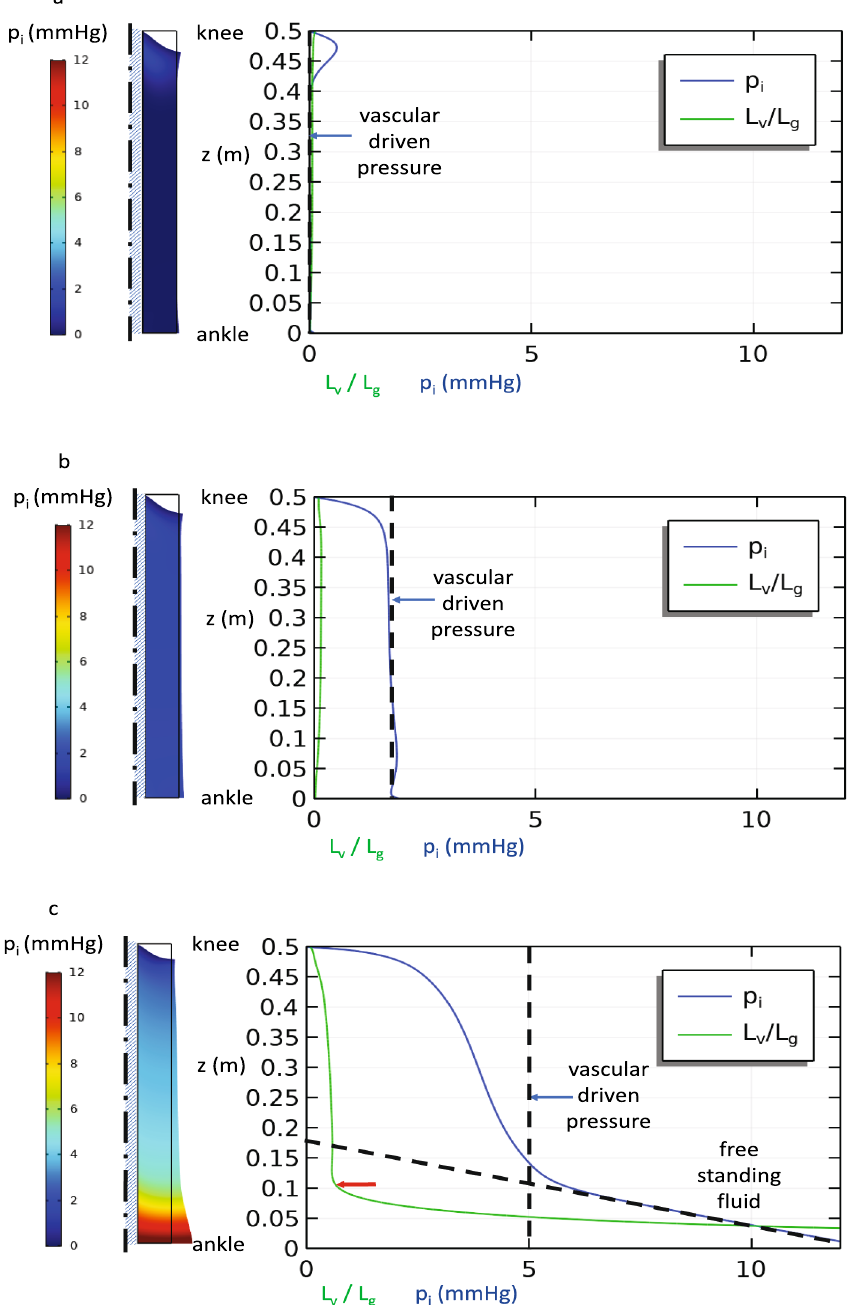
Figure 3. Baseline steady state simulation of the single-layer model with constant lymphatic clearance parameters, but increasing capillary pressure: ( a ) p c = 10 mmHg ( b ) p c = 20 mmHg, and ( c ) p c = 40 mmHg. IFP and L v / L g plotted along the outer surface of the leg. The dashed lines show the IFP expected due to a strictly local balance between the interstitial space and the vasculature as predicted by Eq. (12) at 0 mmHg for p c = 10 mmHg, 2 mmHg for p c = 20 mmHg, and 5 mmHg for p c = 20 mmHg, and a free-standing column of fluid in ( c ). A transition from local vascular-driven pressure to limb-scale, free-standing fluid is apparent when L v / L g increases significantly due to increased interstitial permeability when the tissue expands from high internal pressure below z = 0.1 m at the red arrow in ( c